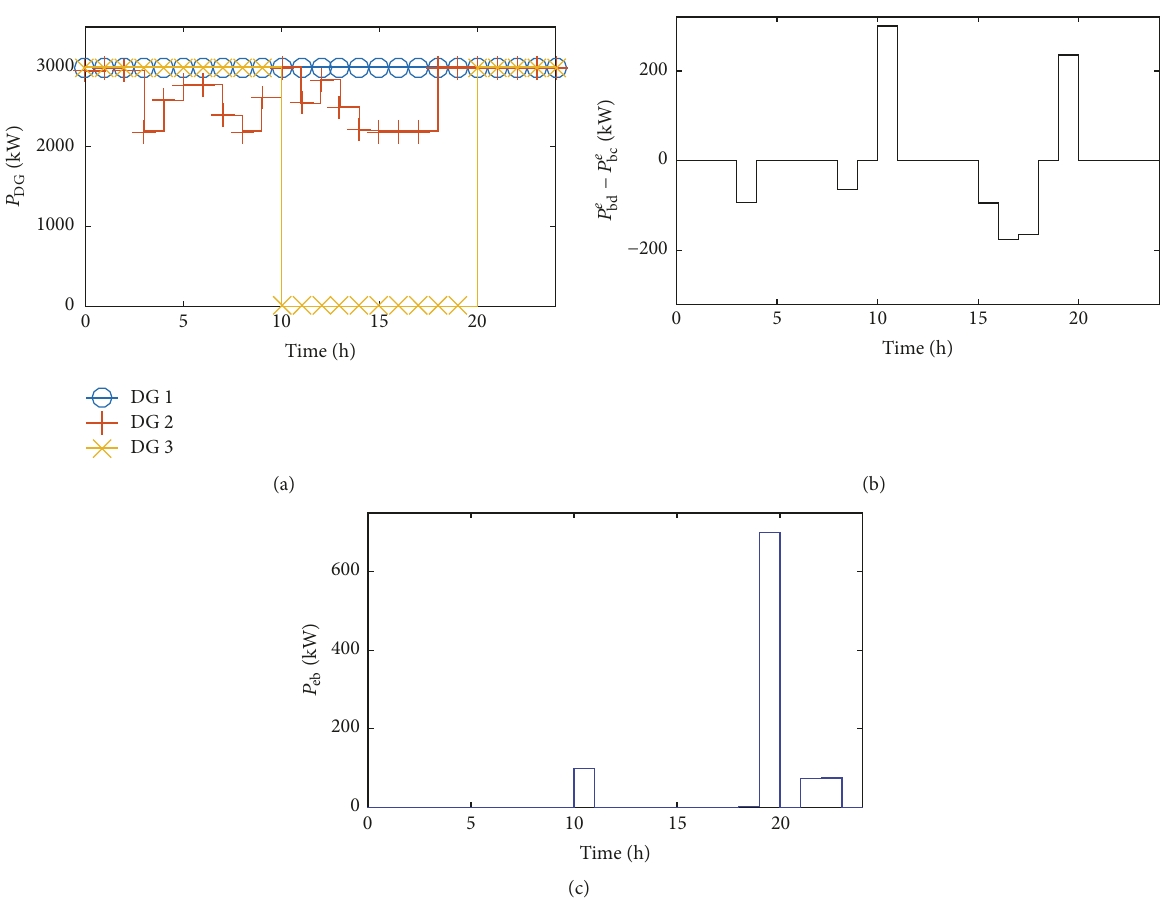
Figure 5: Scenario 3: (a) dispatch values of DG 1, DG 2, and DG 3, (b) BESS charge and discharge profiles, and (c) 𝑃 eb .